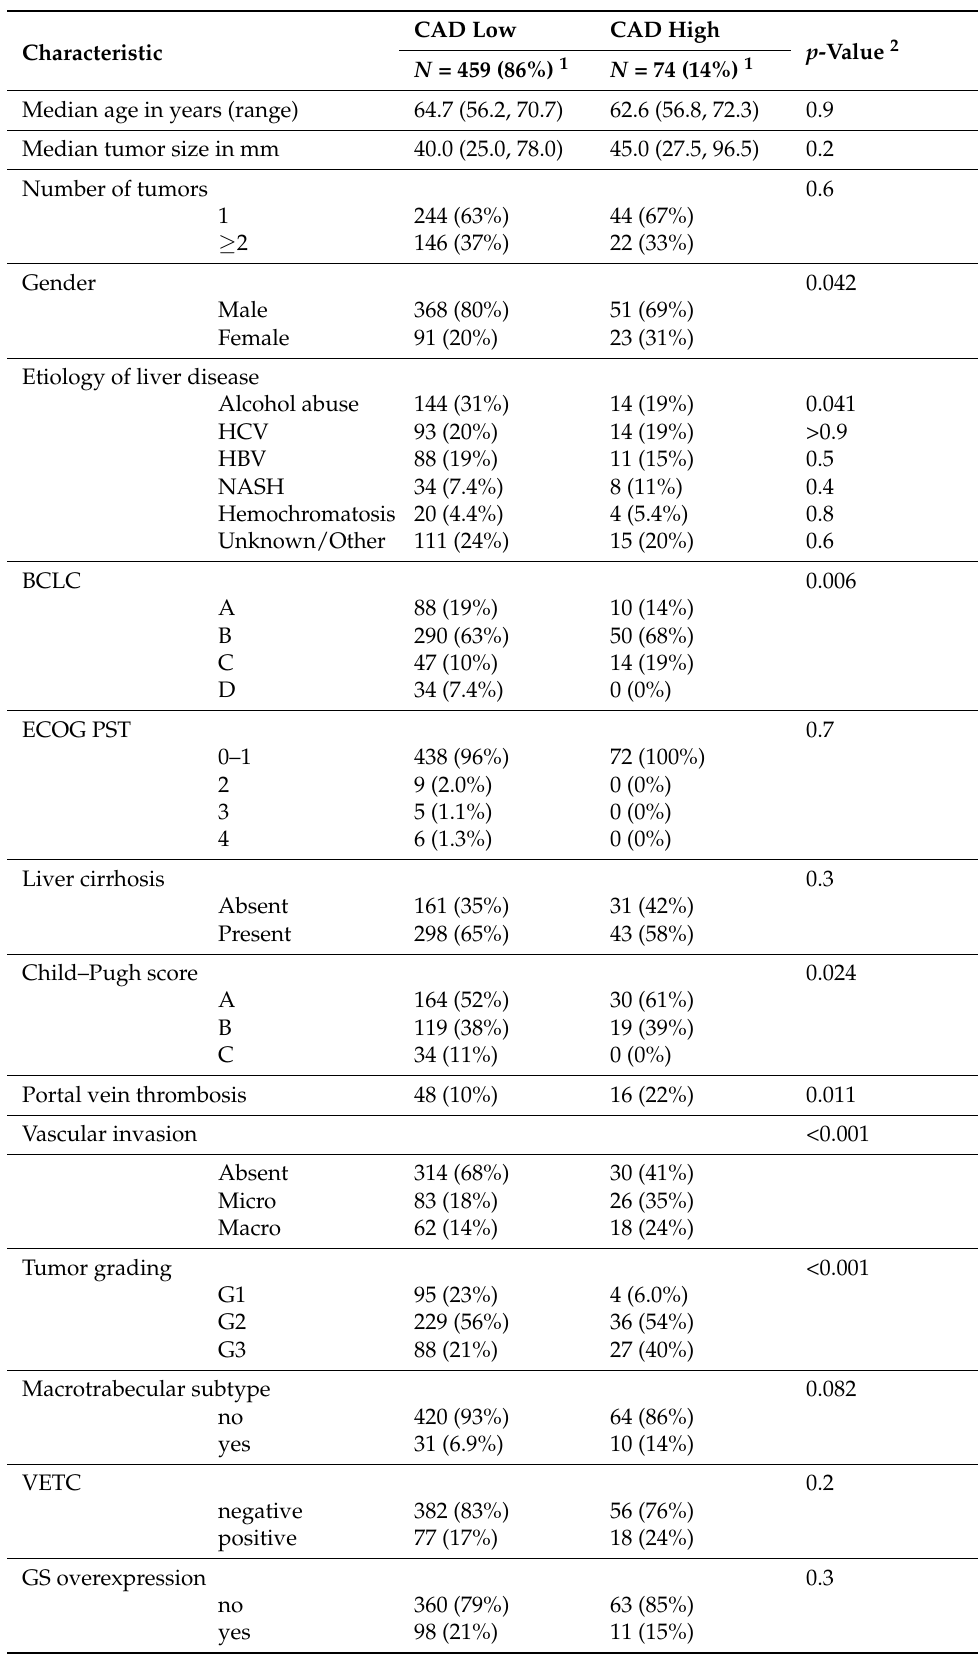
Table 1. Clinicopathologic data associated with high and low immunoreactive scores of